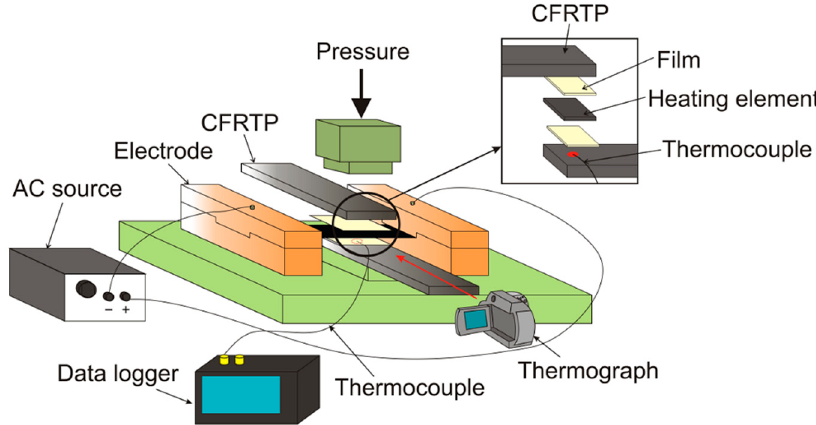
Figure 5. Schematic drawing of experimental setup for measuring the temperature history of welded zone.